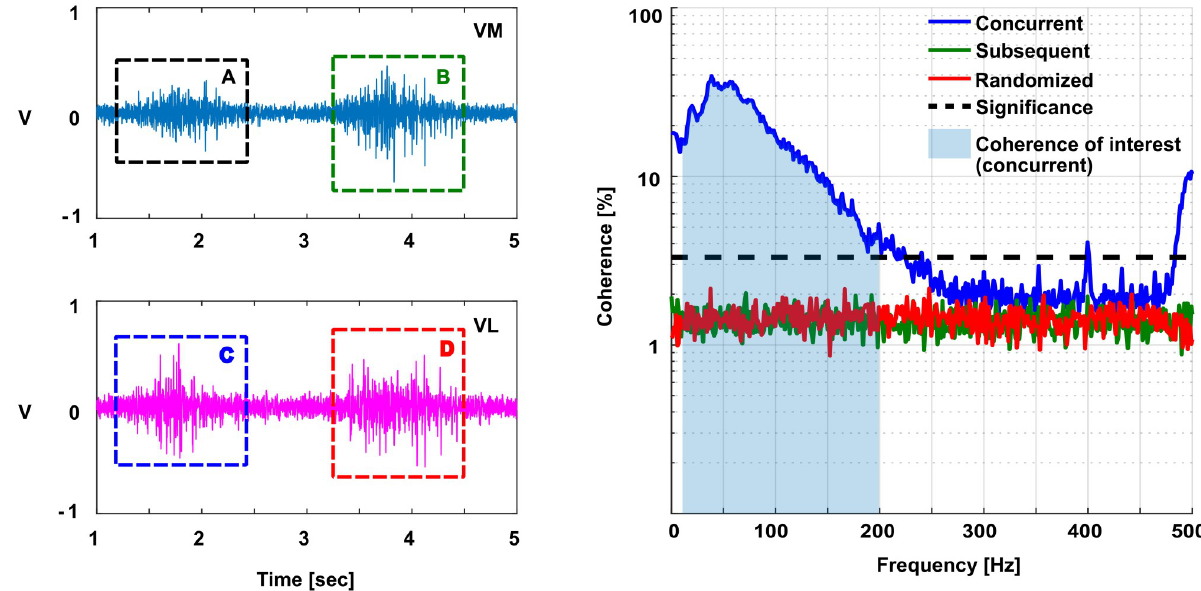
Fig 6. EMG of concurrent activation pairs (A, C and B, D) and EMG of subsequent activations (A, D, and B, C) used to calculate intermuscular coherence (left). Coherence of concurrent (blue), subsequent (green), and randomized (red) activations of one trial ( N = 90 activations)